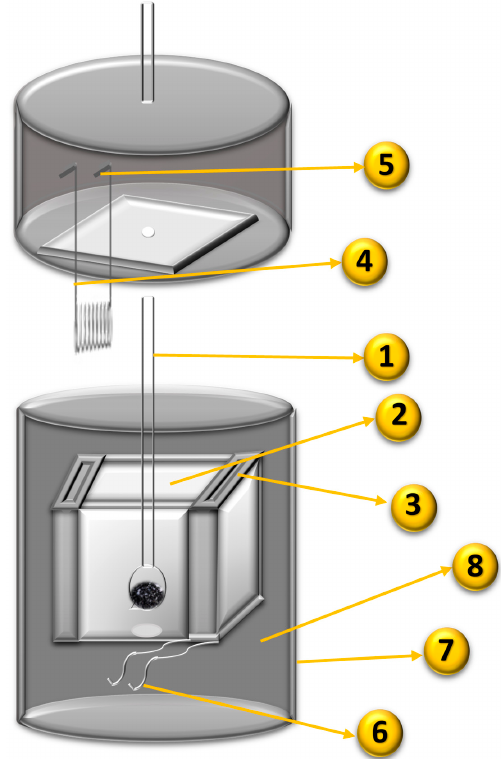
Figure 9. Scheme of the heat conduction microcalorimeter: 1. Glass bulb with fragile brittle end; 2. Cell for the liquid of immersion; 3. Sensors; 4. Resistance; 5. Output connection to power source; 6. Output connection to the multimeter; 7. Cover for insulation; 8. Heat dissipator. Adapted and modified from [73], p. 171.